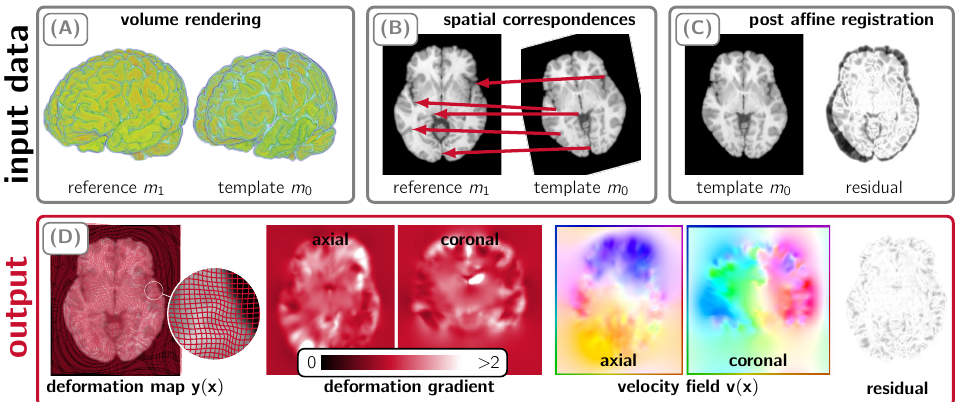
Figure 1. Illustration of the image registration problem. Panel ( A ): 3D rendering of an exemplary set of input images. Panel ( B ): Image registration is the task of computing spatial correspondences between two images of the same object. These correspondences, denoted as y , are indicated by the red arrows for example points within a single axial slice of the template and reference image data shown in panel ( A ). Before we execute CLAIRE , we compensate for the global mismatch between the considered images by performing an affine registration. In panel ( C ), we show an axial slice of the volume shown in panel ( A ) after an affine pre-registration step has been carried out; we execute CLAIRE on these images. Panel ( D ): CLAIRE outputs a diffeomorphic deformation map y that matches each point in the template image m 0 to its corresponding point in the reference image m 1 . We show a typical deformation map y in the leftmost image and the corresponding determinant of the deformation gradient (encodes volume change) in the second and third image from the left (axial and coronal slice). In CLAIRE , we invert for a stationary velocity field v that parameterizes y (second and third figure from the right; color denotes orientation). The last figure in panel ( D ) shows the point-wise residual after applying CLAIRE